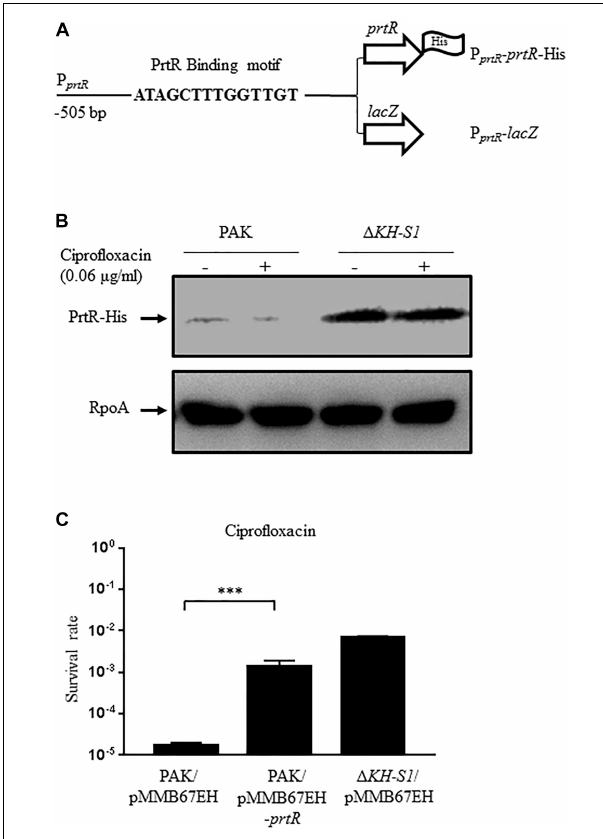
FIGURE 3 | Expression of PrtR in the (cid:49) KH-S1 mutant. (A) Fragments of the prtR promoter region fused with the prtR-His or a promoterless lacZ gene. (B) Protein levels of PrtR-His in PAK and the (cid:49) KH-S1 mutant carrying the P prtR - prtR -His on the bacterial chromosome. The bacterial cells were grown to an OD 600 of 1.0, and then incubated with or without 0.06 µ g/ml ciprofloxacin for 1 h. The PrtR-His levels were determined by Western blotting. RpoA was used as the loading control. (C) PAK containing an empty vector or the prtR overexpression plasmid was grown to an OD 600 of 1.0 and treated with 0.16 µ g/ml ciprofloxacin for 6 h. At indicated time points, the bacterial survival rate was determined by serial dilution and plating. ∗∗∗ p < 0.001 by Student’s t -test.